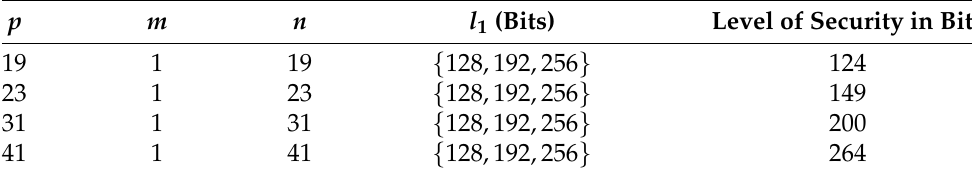
Table 1. Proposed